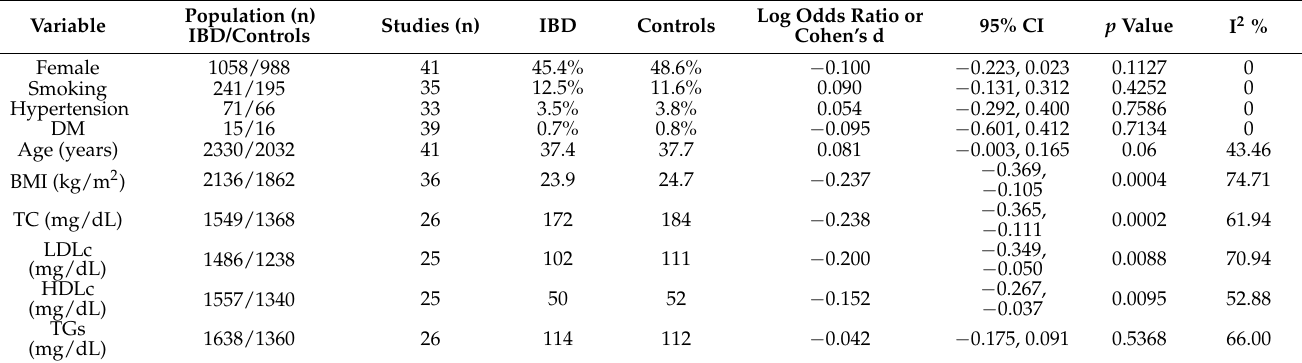
Table 1. Estimated risks and differences in clinical variables between IBD subjects and controls.